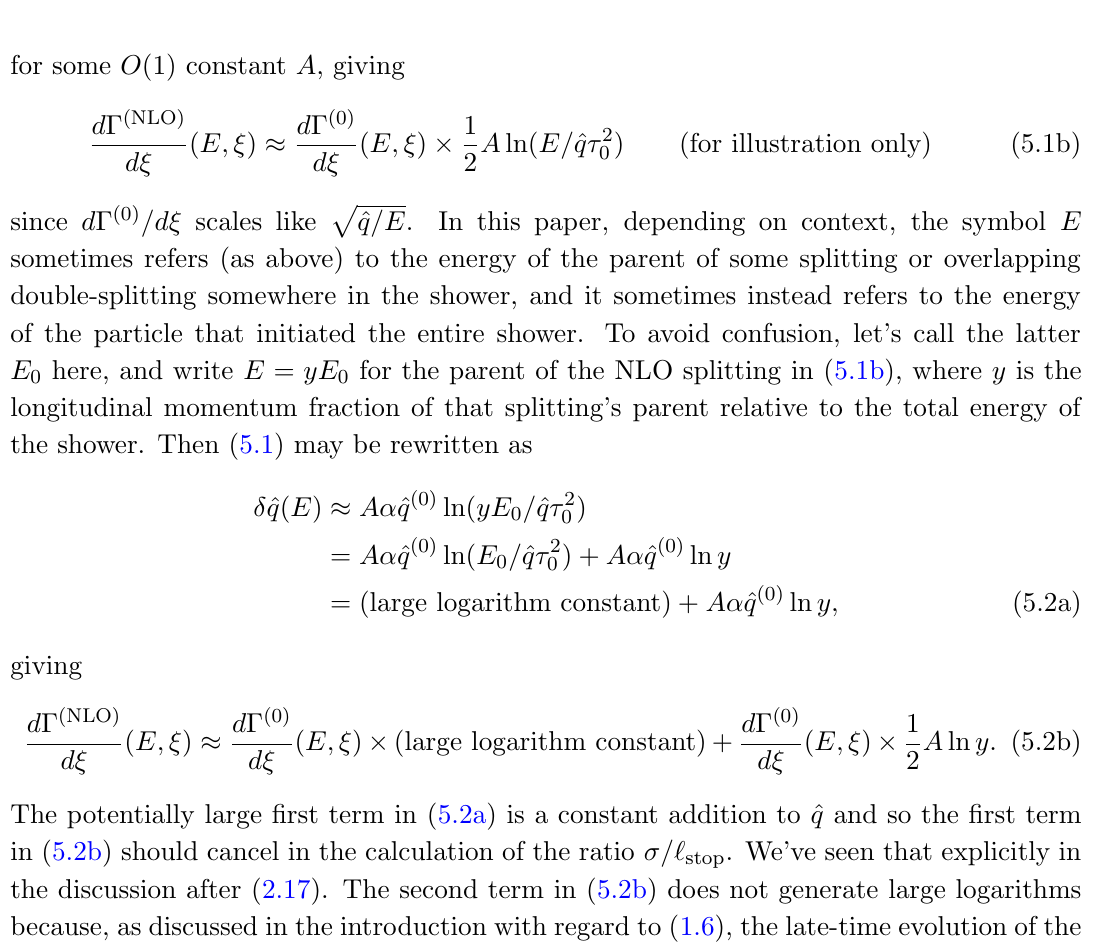
Figure 16 . (cid:22) -dependence of [ N f (cid:11) ( (cid:22) 0 )] (cid:0) 1 (cid:1) ‘ stop =‘ (0) over a nonsensically large range of (cid:22) . The stop two curves are for N f (cid:11) ( (cid:22) 0 ) = 0 : 1 (blue) and N f (cid:11) ( (cid:22) 0 ) = 1 : 0 (orange). The factor of [ N f (cid:11) ( (cid:22) 0 )] (cid:0) 1 scaling the vertical axis is there just to make the two curves comparable on the same plot, given that (cid:1) ‘ stop =‘ (0) is of order N f (cid:11) stop